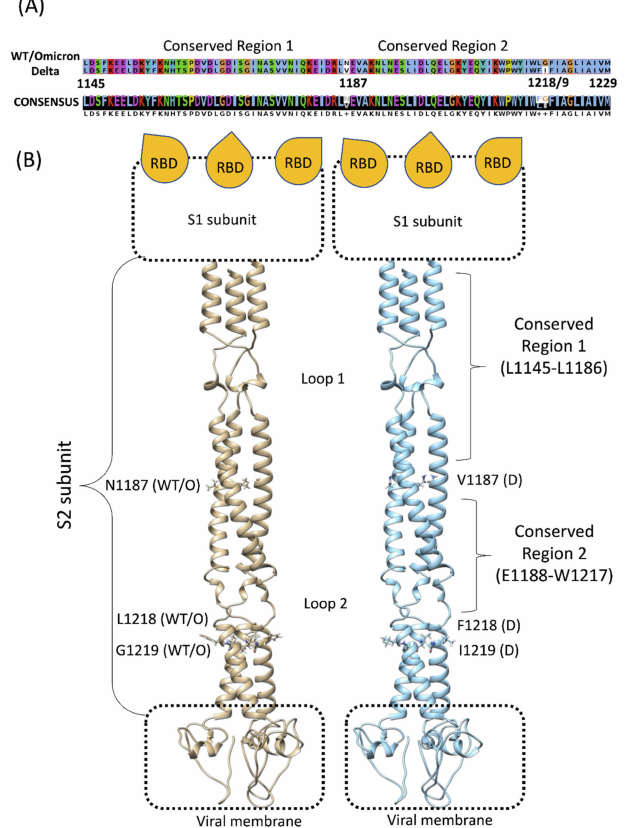
Figure 1. ( A ) Sequence alignment between the conserved SP stalk region of the wild-type (WT) or Omicron and Delta variants. ( B ) Structural comparison between WT or Omicron (tan ribbon) and Delta S2 (cyan ribbon) regions. The segment between residues L1145–W1217 is almost identical between the strains, except for residue 1187, which divides the Conserved Regions 1 and 2. Glycans were removed for clarity; the S1 subunit with the three receptor-binding domains (RBDs) and the viral membrane are schematically